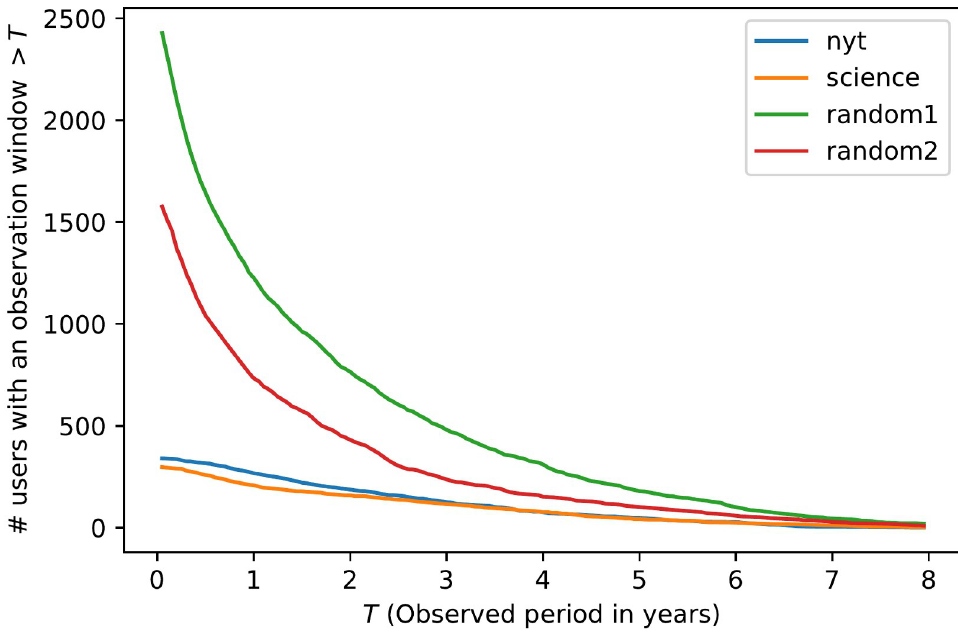
Fig 2. Available timelines. Number of selected timelines depending on the observation